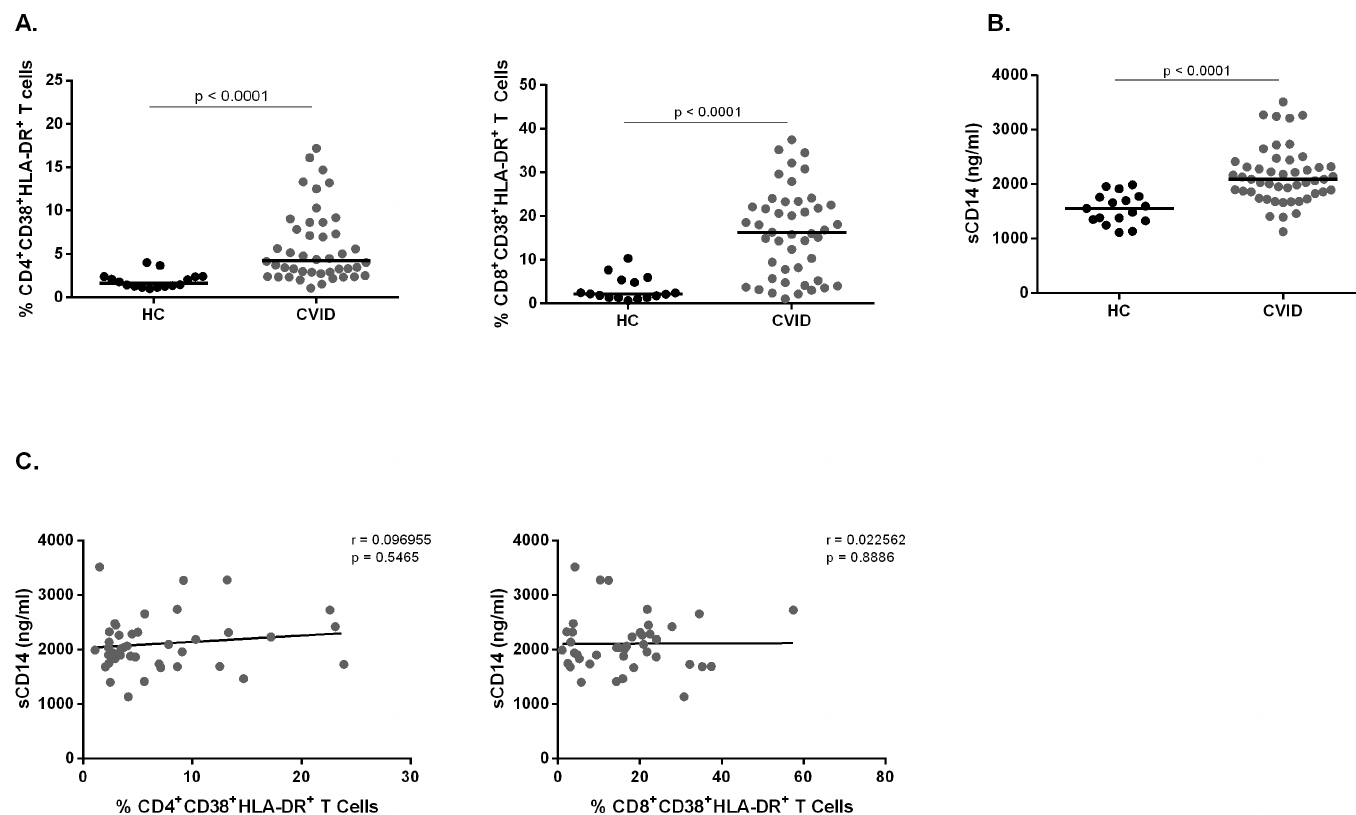
Fig 5. Chronic activation profile in CVID patients. Chronic activated T cells were determined in PBMC from 17 healthy controls and 42 CVID patients by surface markers CD4, CD8, CD38 and HLA-DR expression without stimulation and analyzed by flow cytometry. sCD14 levels were determined by ELISA analysis of plasma from 17 healthy controls and 42 CVID patients. Scatter plots show the percentages of (A) CD4 + CD38 + HLA-DR + and CD8 + CD38 + HLA-DR + chronic activated T cells and (B) plasma levels of sCD14. (C) Correlation of sCD14 with the frequencies of chronic activated CD4 + and CD8 + T cells in CVID patients. Bars represent the mean value. P values were calculated by Mann-Whitney test. Lines represent linear regression analysis. R and P values were calculated by Spearman ’ s rank order correlation